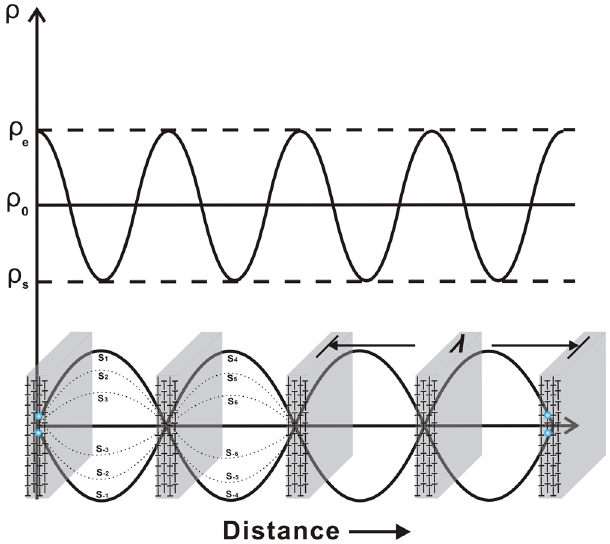
Figure 2. Formation mechanisms of periodic PSB ladders induced by standing wave effect in dislocation